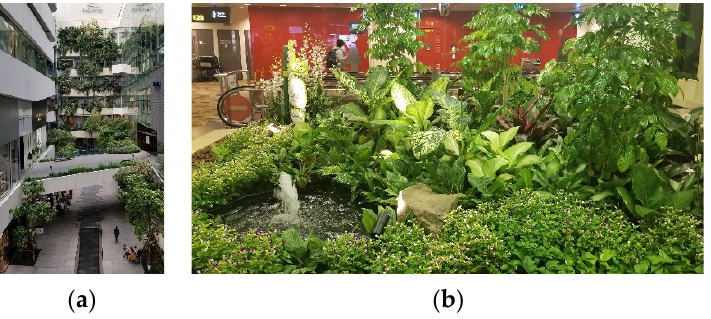
Figure 1. Views of interior green spaces: ( a ) a vertical garden in an atrium and ( b ) an indoor garden in corridors.